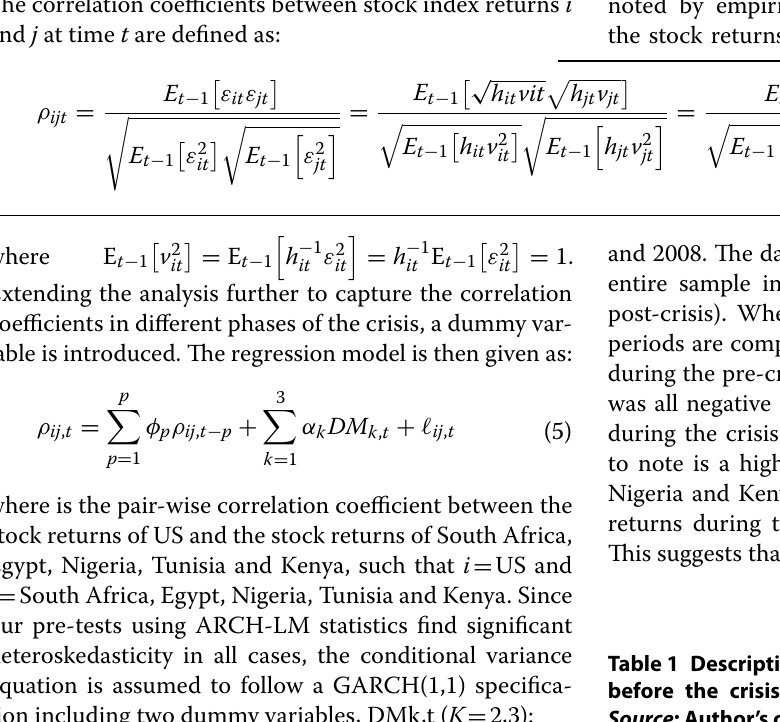
before the crisis, during the crisis and after the